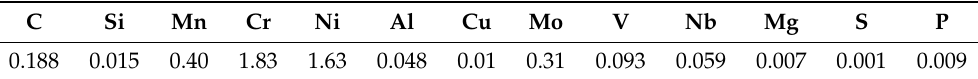
Table 1. Chemical compositions of 17Cr2Ni2MoVNb steel (wt. %).